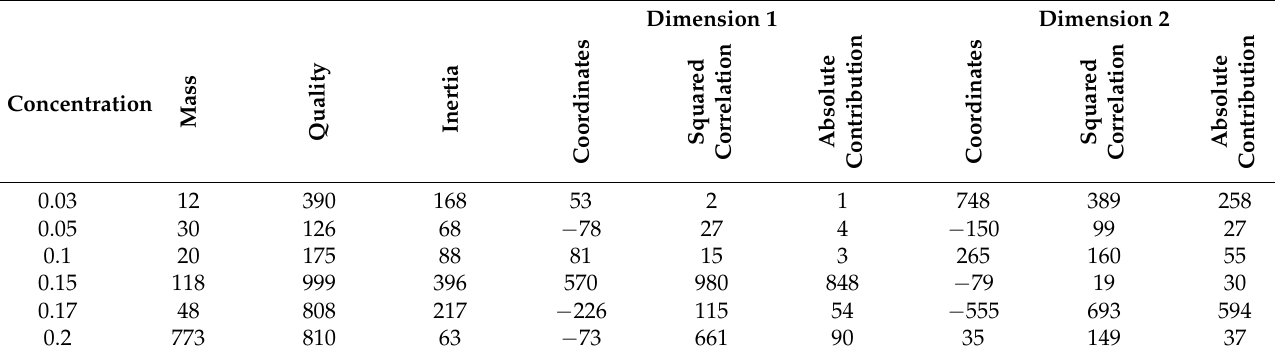
Table 3. Result summary for the second